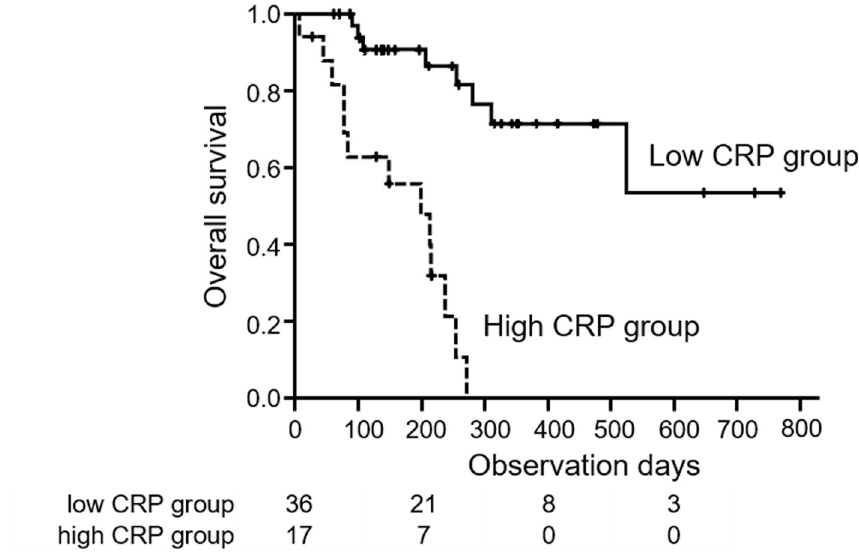
Fig 1. Overall survival with unresectable HCC treated with lenvatinib in high and low CRP groups. The low CRP group (solid line) showed a significantly better prognosis than the high CRP group (dotted line) (71.5% vs 0.0%/ 1year, log-rank test; p <